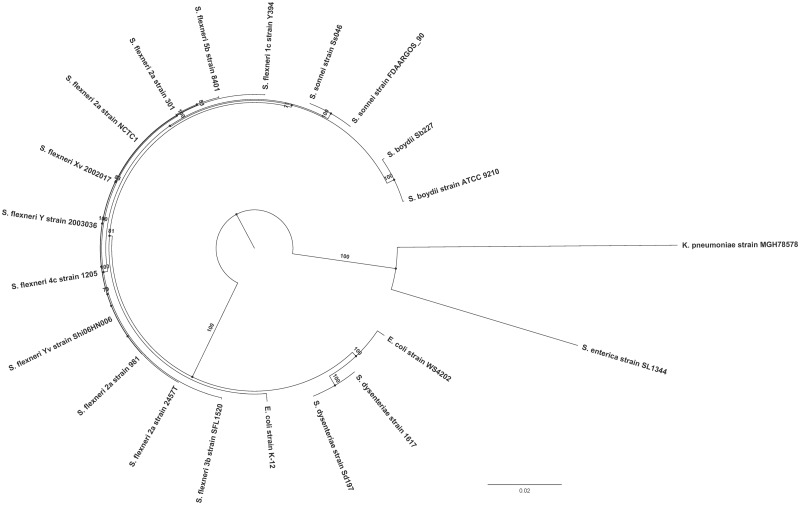
—Phylogeny of S. flexneri. The maximum likelihood tree using core genes of the representative S. flexneri strains and other Shigella species rooted using members of other genera. The numbers indicate bootstrap support values >70 (1,000 pseudoreplicates). The scale bar represents substitutions per site.